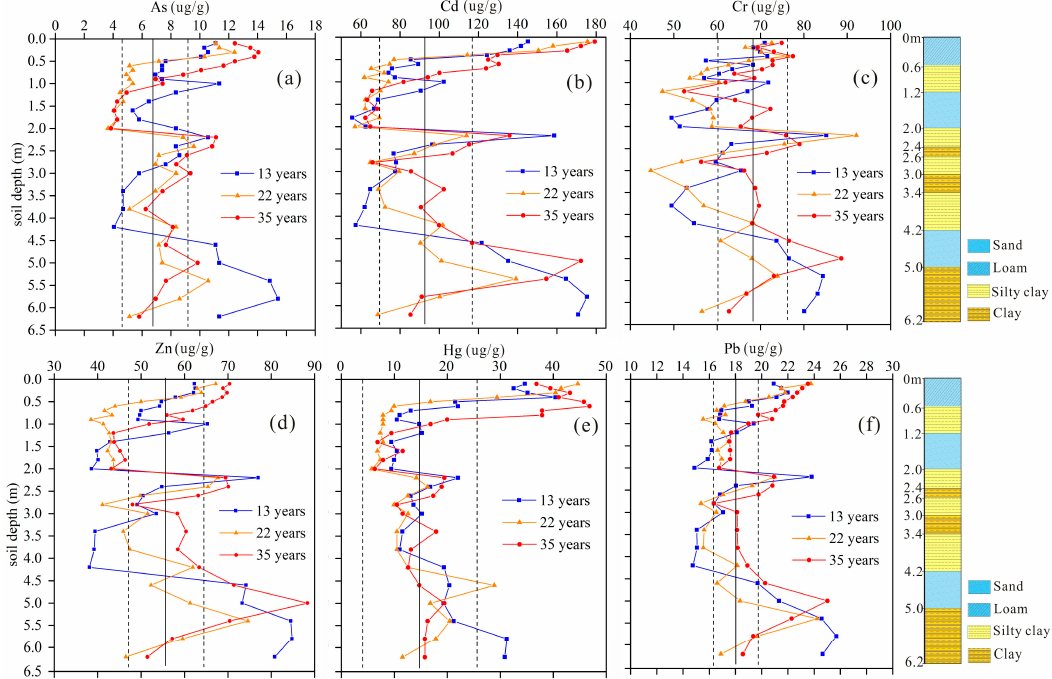
Figure 3. PTEs values in soil profiles with different irrigation times. Solid line represents the mean value of control plot, and dashed lines represent corresponding standard deviations.